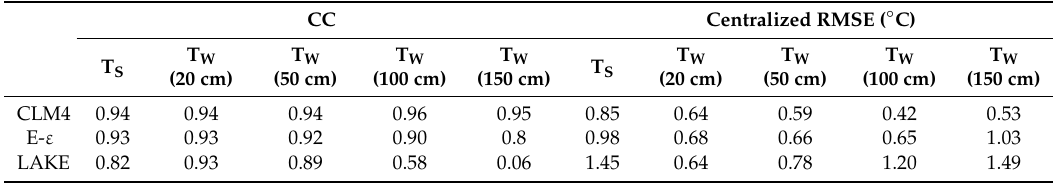
Figure 3. Simulation of lake surface temperature at the BFG site of Taihu Lake in August 2012. Table 3. Statistical analysis of simulated and observed values in different layers of lake water temperature in Taihu in August 2012.